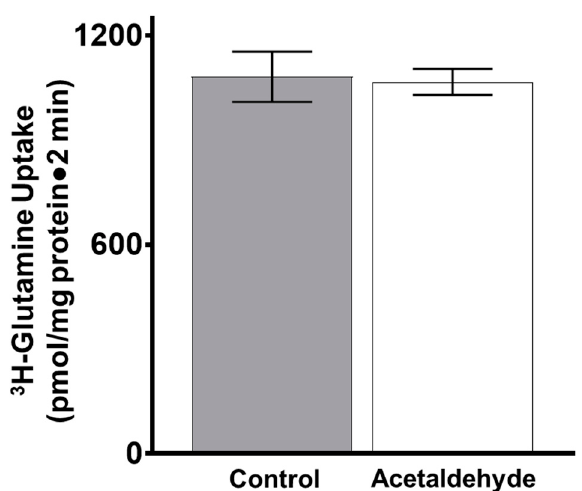
Figure A4. Acetaldehyde did not alter glutamine absorption in IEC-18 cells. Sodium-dependent glutamine activity was determined using 3 H-glutamine uptakes with and without a sodium-free condition in the presence and absence of 15 µM acetaldehyde after one hour ( p > 0.05, n = 4). The error bars represent the SEM.